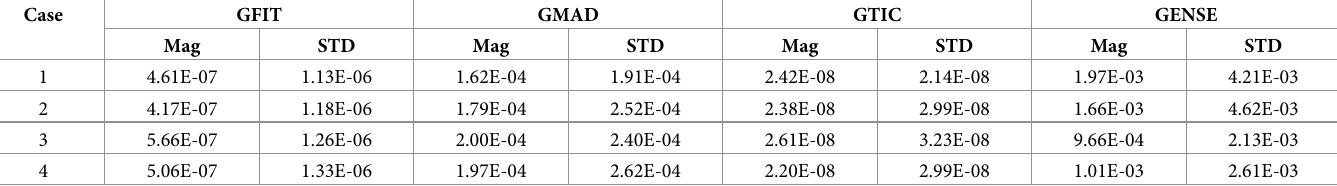
Table 6. Global performances for problem 2.